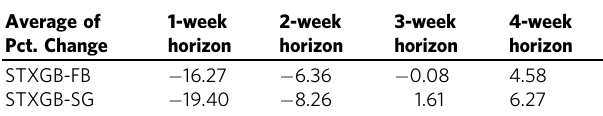
Table 4 Average percentage improvement in prediction MAEs achieved by our STXGB models compared to COVIDhub-Ensemble model over four prediction horizons. Average of Pct.